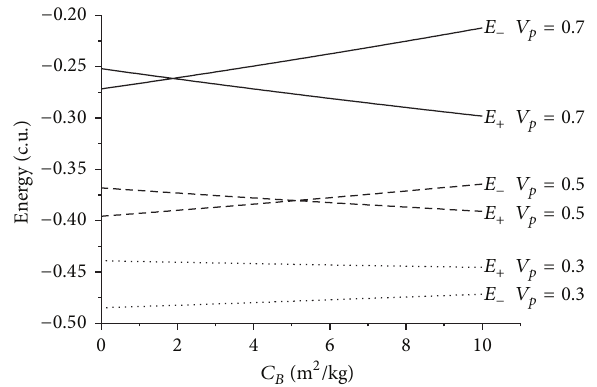
Figure 7: Evolution of the energies as a function of the ballistic coefficients for near-parabolic orbits for 𝜓 = 270 ∘